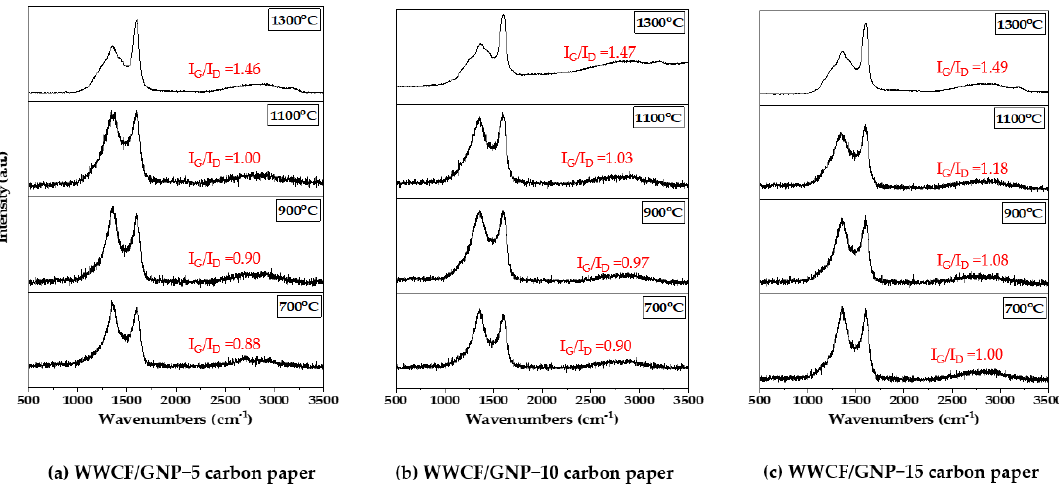
Figure 4. Raman spectra of waste wood cellulose fiber/graphene nanoplatelet (WWCF/GnP) carbon papers.